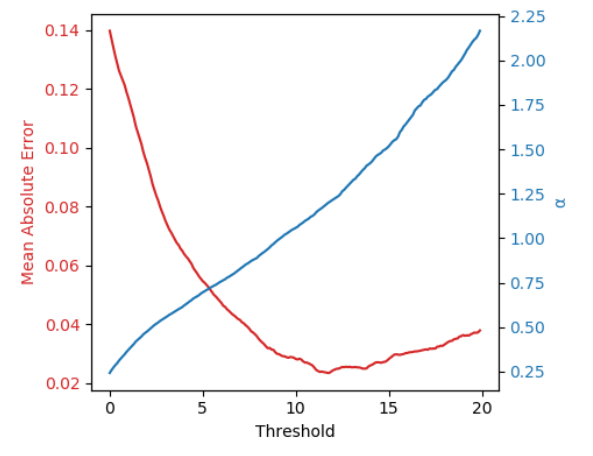
Figure 6. Adjusted Mean Absolute Error and α coefficient depending on the threshold chosen for C/DiffMedSigmaT .